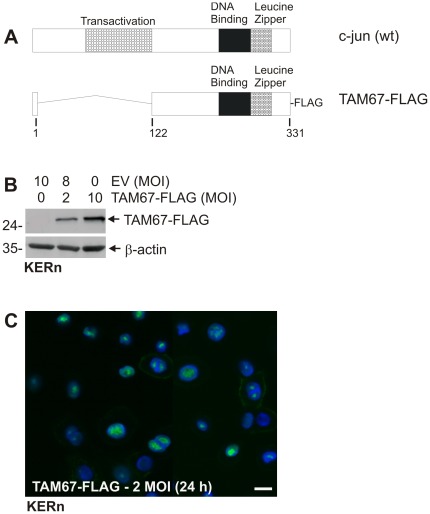
TAM67-FLAG expression in keratinocytes. AComparison of c-jun and TAM67 structure. The numbers are indicated in amino acids. The transactivation, DNA binding and leucine zipper domains are indicated. The TAM67 truncated protein is FLAG epitope tagged as indicated. B/C TAM67-FLAG is expressed in keratinocytes. Normal human keratinocytes were infected with 10 MOI of tAd5-EV or tAd5-TAM67-FLAG with 5 MOI of Ad5-TA. After 24 h the cells were fixed for immunostaining and extracts were prepared for immunoblot with anti-FLAG. Similar results were observed in each of three repeated experiments.